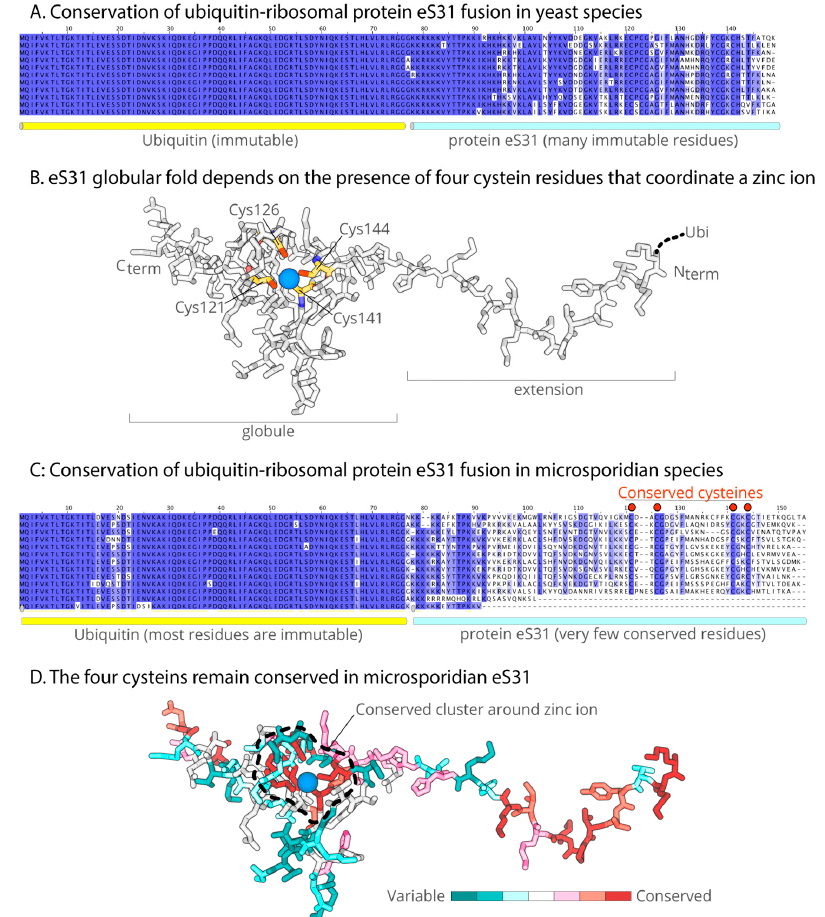
Figure 2. In parasites Microsporidia , ribosomal protein eS31 turns into a poorly conserved peptide with only a few residues remaining conserved due to their critical role in protein folding. ( A ) In most eukaryotes, protein eS31 is produced as a fusion with ubiquitin. During ribosome biogenesis, ubiquitin-eS31 fusion is being cleaved into ubiquitin and eS31. The panel illustrates sequence conservation of ubiquitin-eS31 in yeast species, where ubiquitin sequence remains immutable, and eS31 sequence has more than 80% identity between yeast species. ( B ) Crystal structure of eS31 protein shows that the folding of eS31 critically depends on the presence of a zinc-finger motif. The zinc-finger motif is required to stabilize the folding of the eS31 globular domain because the hydrophobic interactions in the globule of this small protein are too weak to keep its polypeptide chain folded. ( C ) In Microsporidia , the ubiquitin sequence remains highly conserved, with only ~10% of sequence showing moderate variations, whereas the eS31 sequence becomes into highly variable, with only six residues being conserved between microsporidian species. Four of these residues (all cysteines) coordinate a zinc ion in the middle of eS31 globular domain to form a zinc-finger motif that is used to anchor eS31 in the ribosome structure. ( D ) The crystal structure of protein eS31 is colored by conservation of amino acid residues across microsporidian species (calculated by using the ConSurf server at http://consurf.tau.ac.il/2016/) (access on 12 November 2018). The cluster of conserved residues around zin ion is outlined to show that the most conserved residues are clustering around the zinc ion. High conservation of the four cysteine residues in eS31 in Microsporidia suggests that there is selective pressure to keep eS31 properly folded, which is possibly to avoid the formation of protein aggregates that would intoxicate microsporidian cells or would compromise ubiquitin biosynthesis. Overall, the figure illustrates that that, despite an apparent loss by eS31 its original role in protein synthesis, this protein is still retained in the microsporidian proteome for its extraribosomal role in ubiquitin